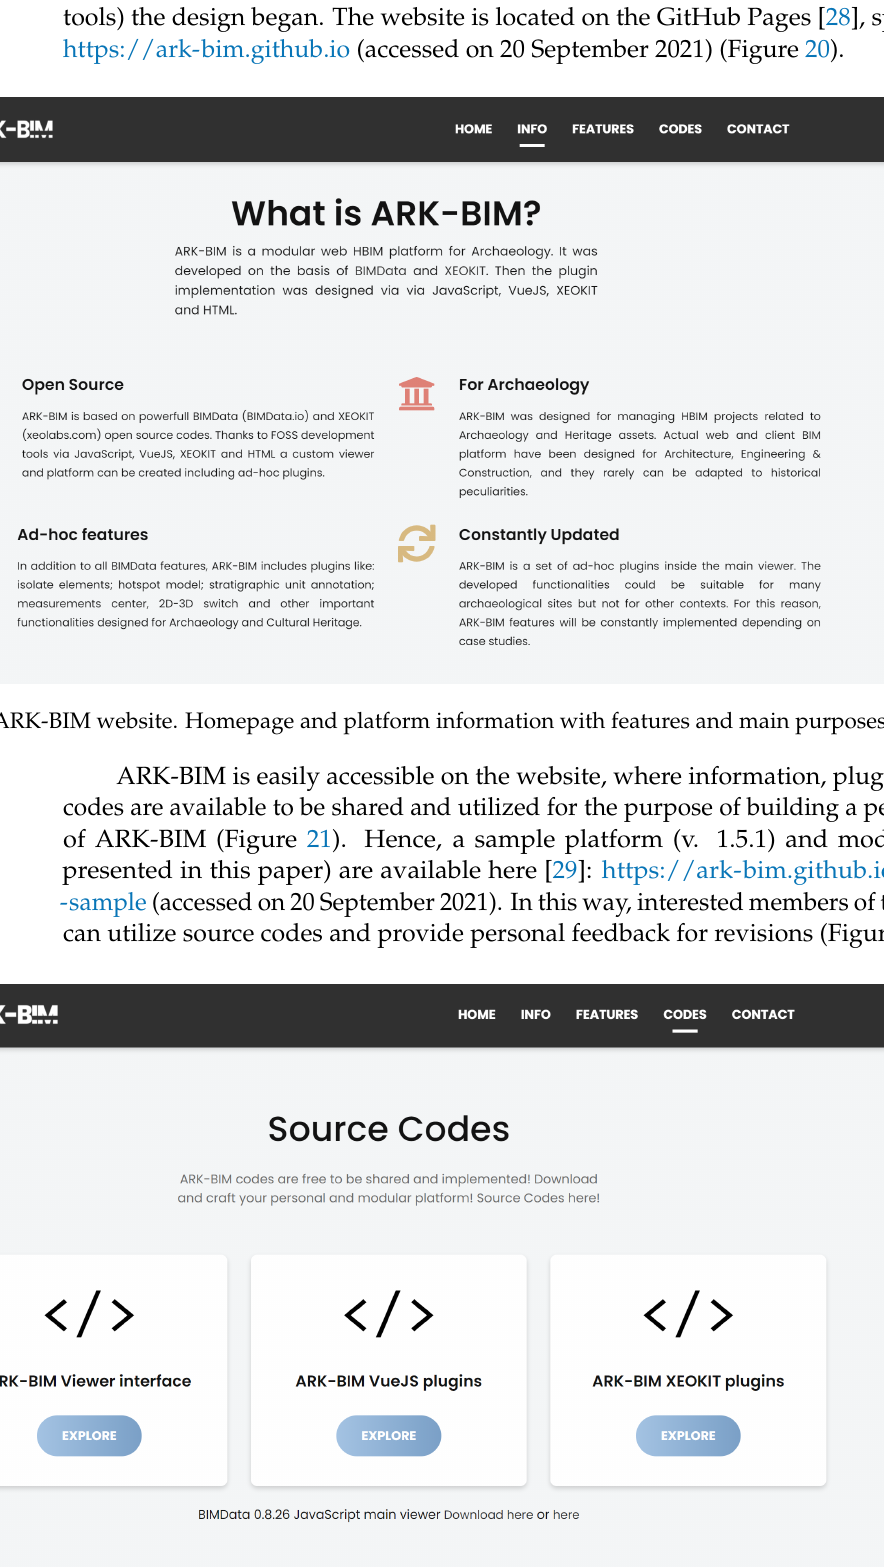
16 of 21 Figure 19. ARK-BIM (version 1.5.1): Measurement Centre plugin, sample of angle measurements. The correct plugin implementation (both VueJS and XEOKIT) ends with the graph- ical inclusion of buttons on either side of the viewer interface. Plugins can be rendered in three ways: without style; next to the button in a sized window; next to the button in a movable and resizable window.